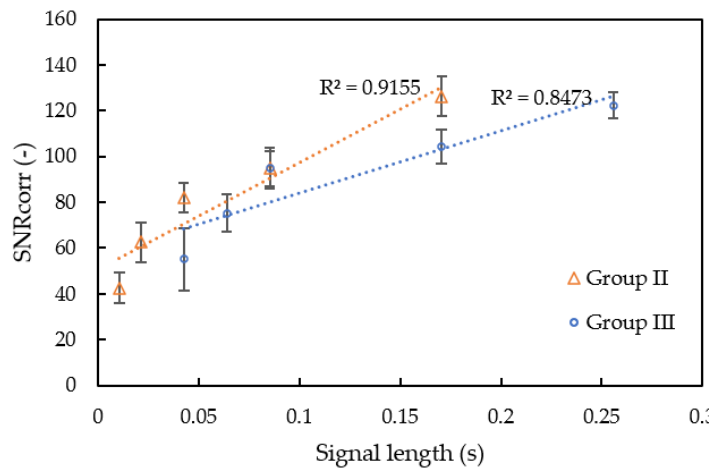
Figure 9. Noise tolerance change with M sequence length ( a ) and chip rate ( b ).